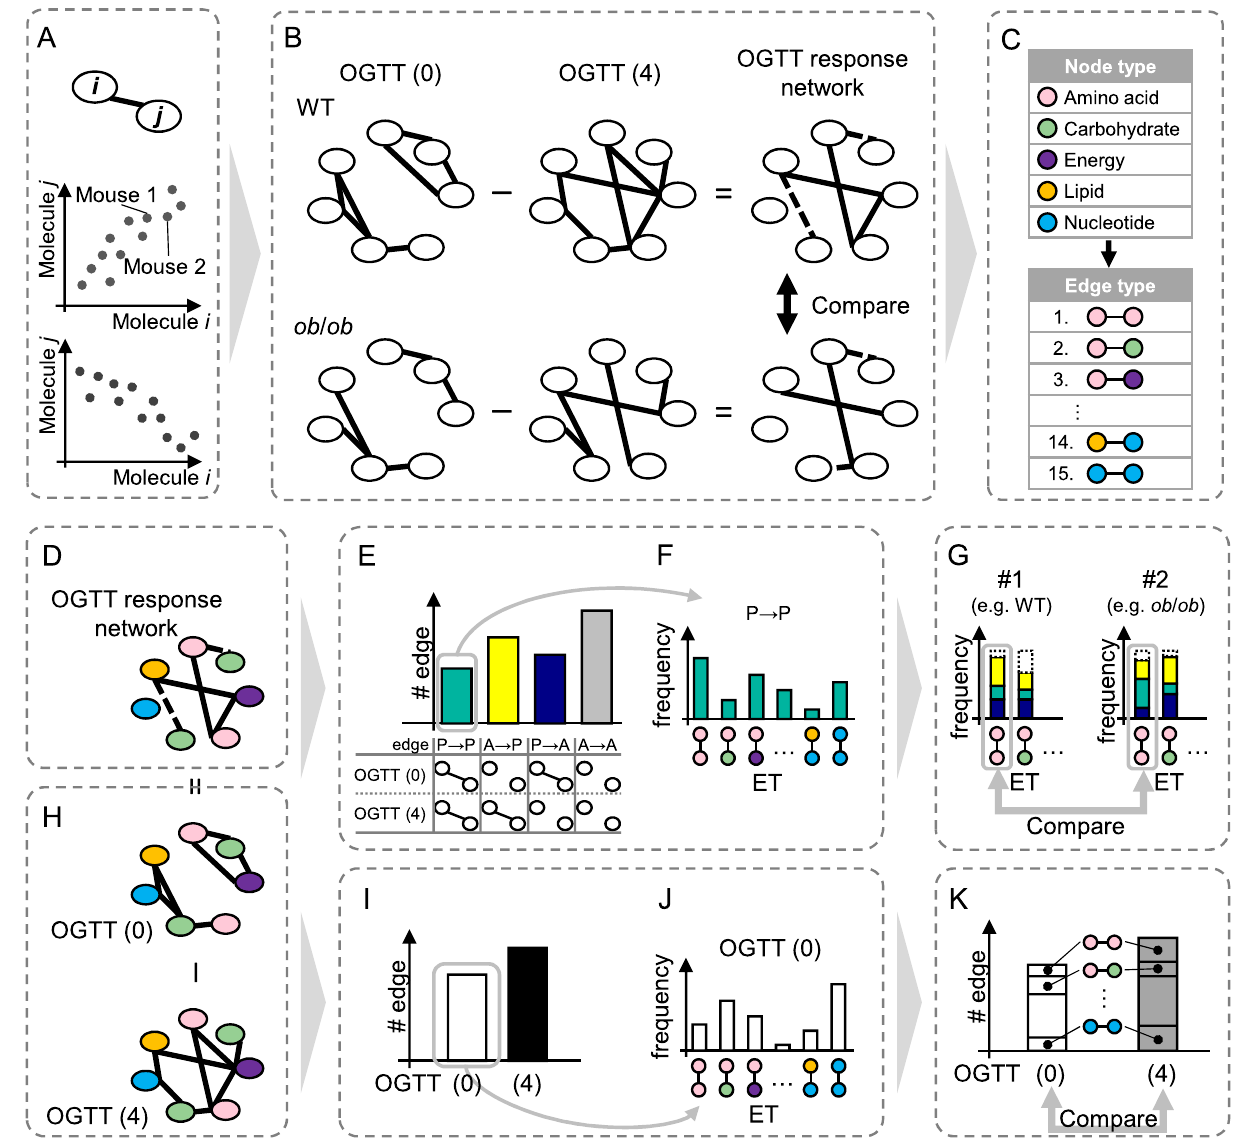
Figure 1. Schematic representation of the network inference, the network comparison, the definition of the edge type, and the comparison of ET distribution. ( A ) Evaluation of the relationships between the molecular species (metabolite or gene) by statistical independence. The nodes are connected by the edges, given that the mutual information 17 between nodes is not statistically 0 ( p < 0.05, permutation test). ( B ) Inference of the OGTT (0) network, the OGTT (4) network, and the OGTT response network and the comparison of the OGTT response network between WT and ob / ob . OGTT (0) and OGTT (4) represent for the conditions prior to and following the OGTT, respectively. ( C ) Definition of ETs. ( D – G ) Comparison of the OGTT response networks using the defined ETs. ( H – K ) Comparison of each condition’s networks using the ET distribution. ( D , H ) The OGTT response network and the network of OGTT (0) and OGTT (4). Nodes with different colors are different node types. ( E ) The number of the OGTT response edges. “P → P,” “A → P,” “P → A,” and “A → A” stand for the edges that were are common to the OGTT (0) and OGTT (4) networks, the edges only existing in the OGTT (4) network, the edges only existing in the OGTT (0) network and the edges existing in neither OGTT (0) nor OGTT (4) networks, respectively. ( F ) The ET distribution of each OGTT response edge. An example for P → P edges is shown. ( G ) The comparison of OGTT response edge distribution between each OGTT response network. #1 and #2 stand for the OGTT response network 1 and 2, respectively. ( I ) The number of each condition’s edges. ( J ) The ET distribution of each condition’s edges. An example for OGTT (0) is shown. ( K ) The comparison of ET distribution between each